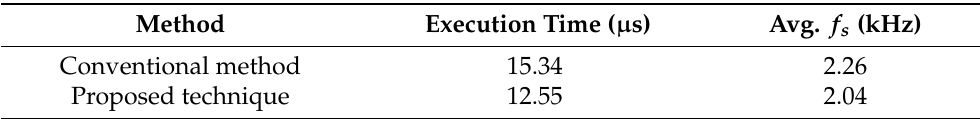
Table 5. Execution time and average switching frequency for inverter control